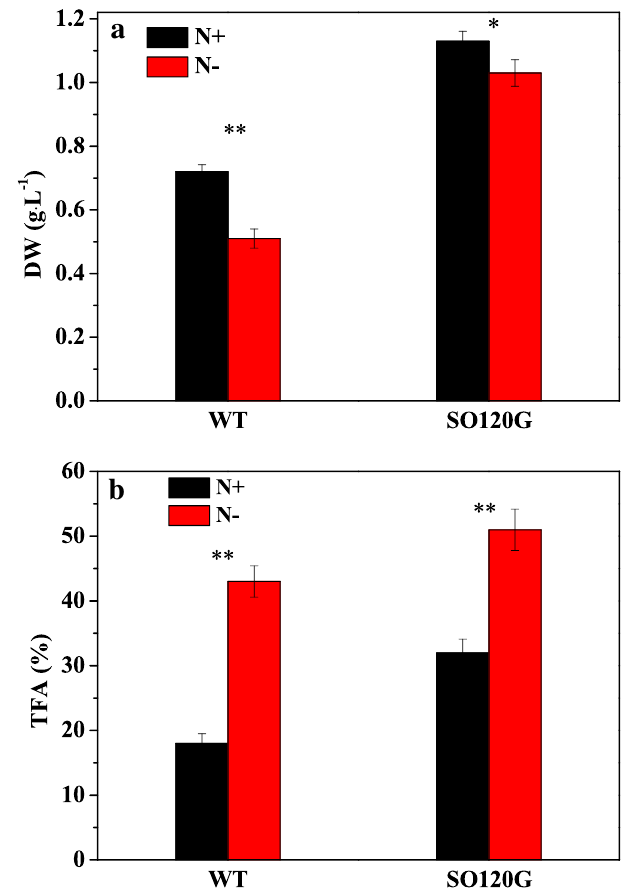
Figure 2. Biomass and total lipid contents of the WT and mutant SO120G under the N + and N- culture conditions. ( a ) Biomass of the WT and SO120G and ( b ) the TFA content of the WT and SO120G, *represents a significant effect ( p < 0.05), and **represents a very significant effect ( p < 0.01).